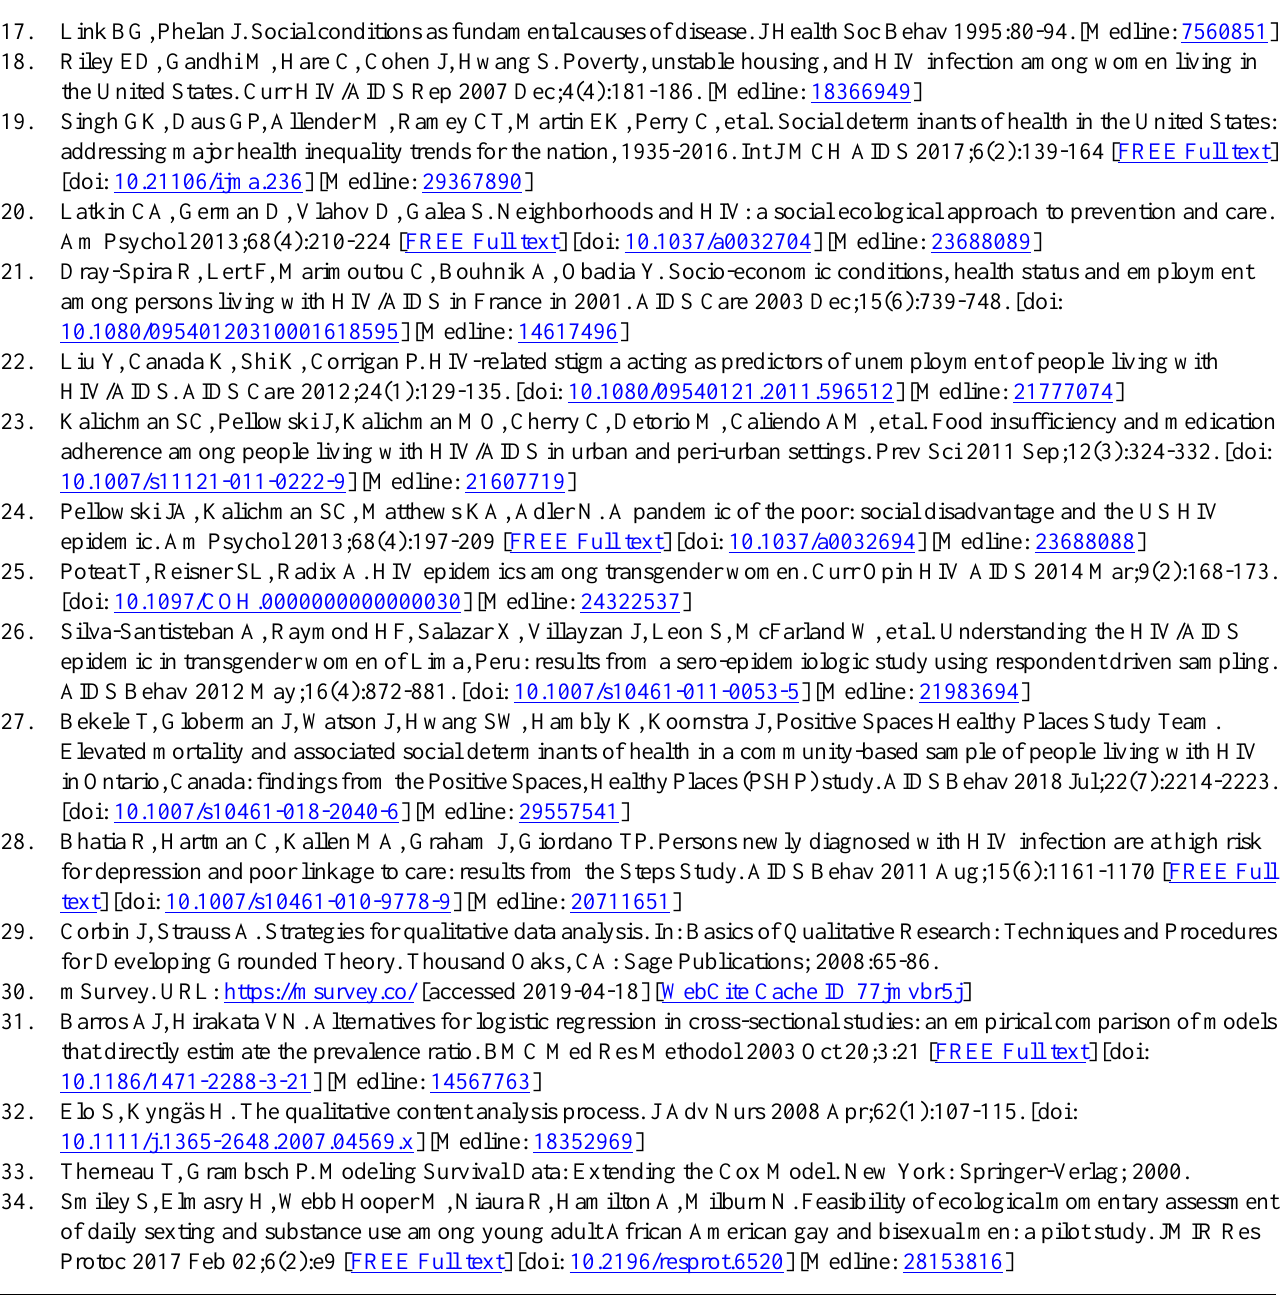
CASI: computer-assisted self-interviewing CI: confidence